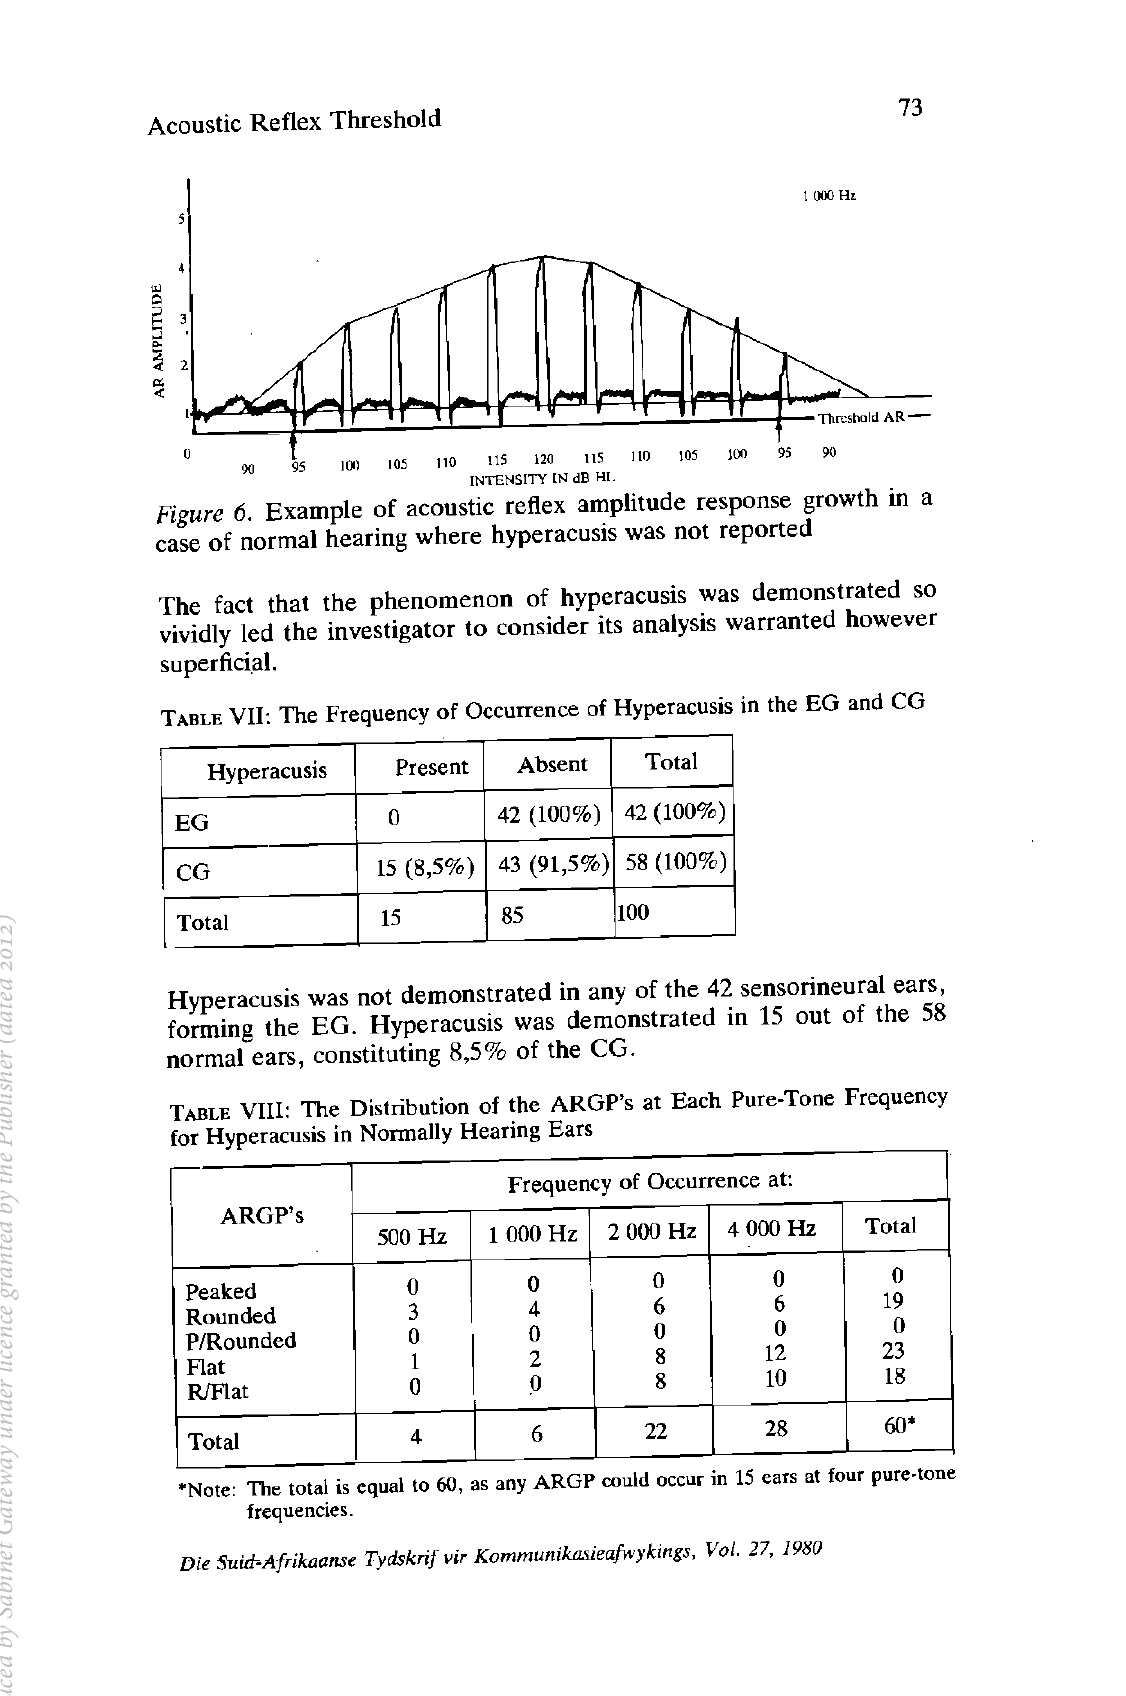
Frequency of Occurrence at: 500 Hz 1 000 Hz 2 000 Hz 4 000 Hz 0 0 4 3 0 0 2 1 0